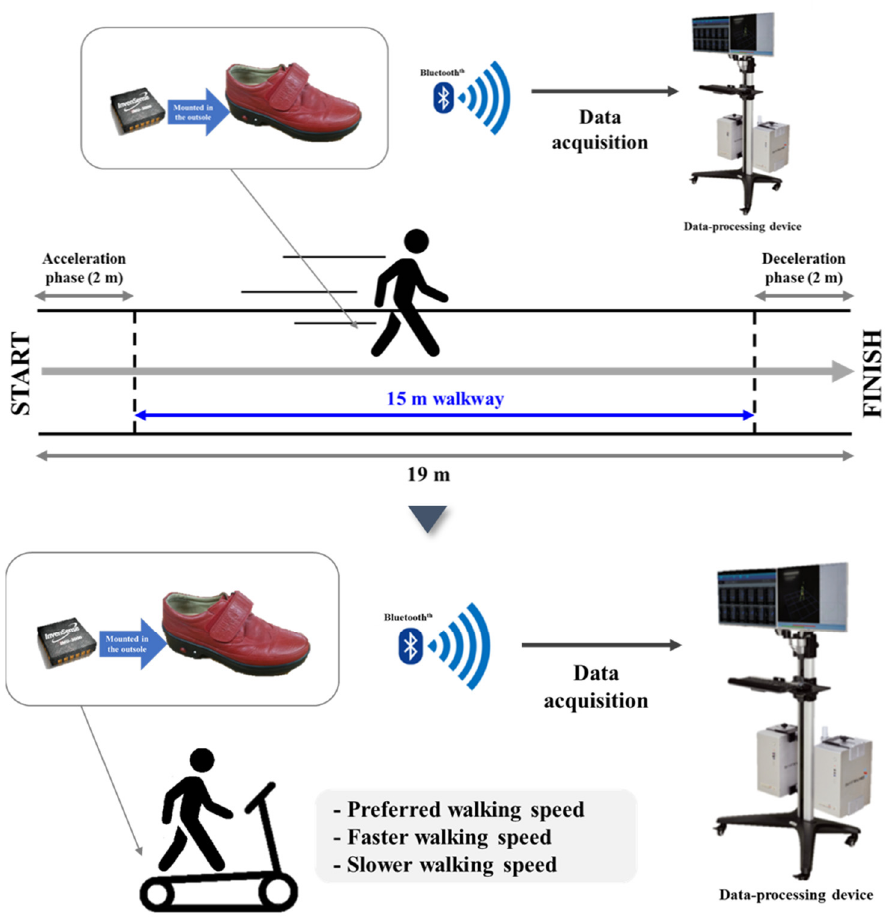
Figure 2. Treadmill walking tests: Preferred speed, 20% faster than preferred speed, and 20% slower than preferred speed.